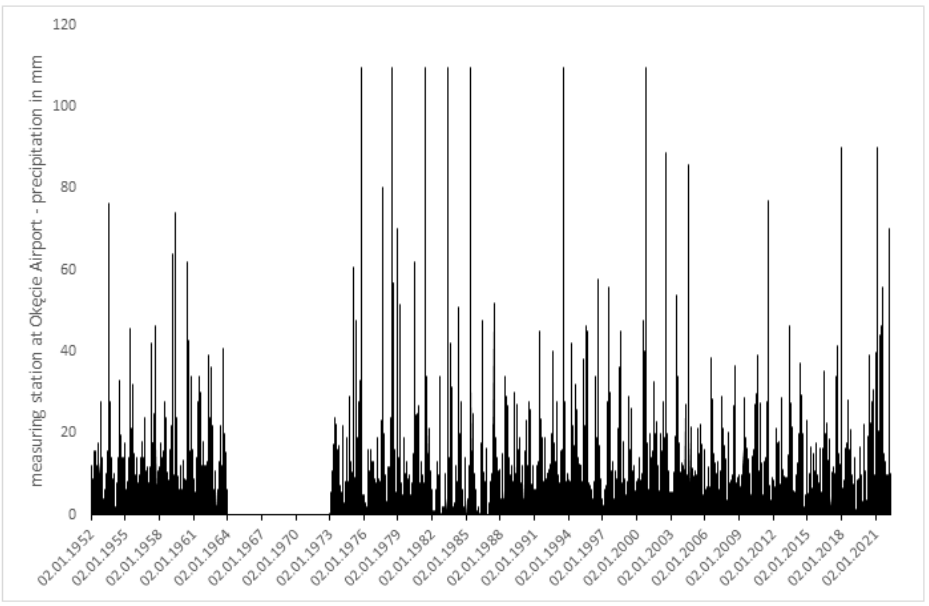
Figure 5. Warsaw Ok ę cie Airport measuring station—Daily Precipitation in mm (source: own elab- Figure 5. Warsaw Ok˛ecie Airport measuring station—Daily Precipitation in mm (source: own oration).